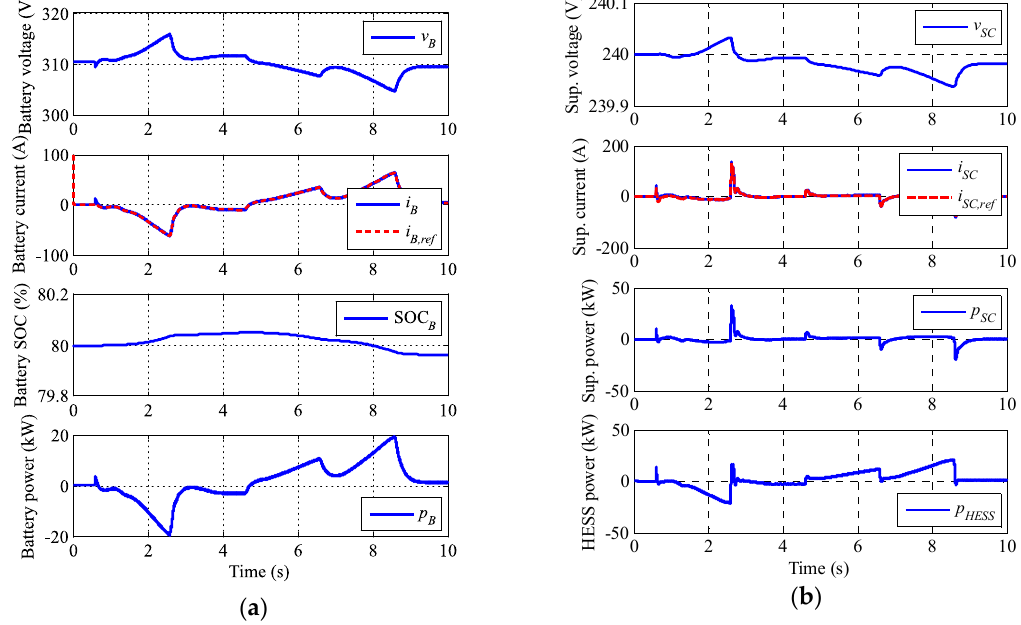
Figure 10. Simulation results: ( a ) Battery magnitudes and ( b ) supercapacitor magnitudes and HESS power.